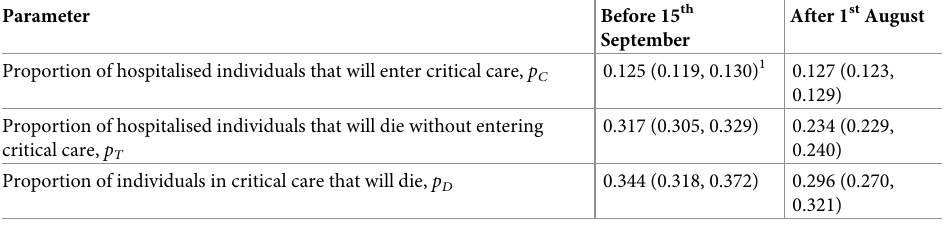
Table 4. Posterior estimates for hospital pathway proportions during 2020. Note that these periods overlap because some historic data were needed to fit the second wave.